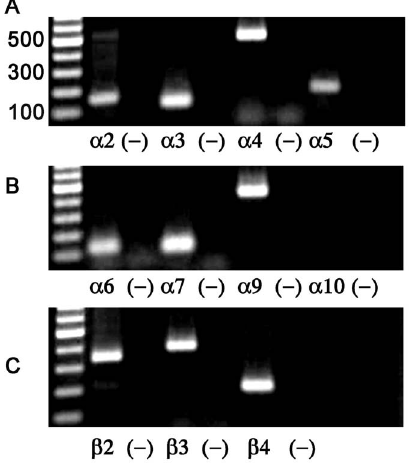
Figure 3. PCR analysis of the nAChR subunit transcripts present in monkey adrenal gland. A-C, PCR products for the nAChR subunits a 2– a 7, a 9, a 10, and b 2– b 4 were analyzed by agarose gel electrophoresis and visualized using ethidum bromide fluorescence. Negative controls for each reaction were performed by omission of the cDNA template and the results are shown in the lanes immediately to the right for each respective subunit.